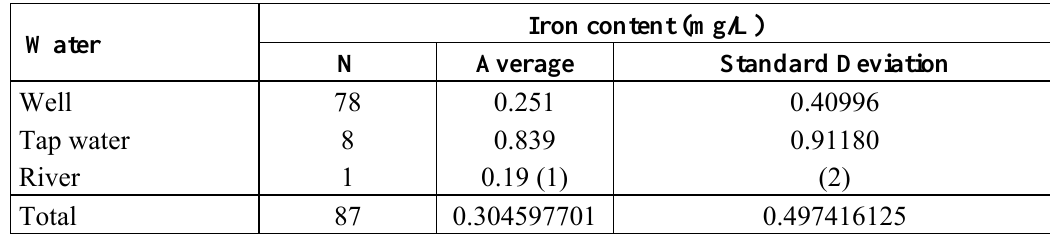
Table 4. Number of samples, average and standard deviation of iron content in water source, Caapiranga, AM, Brazil,